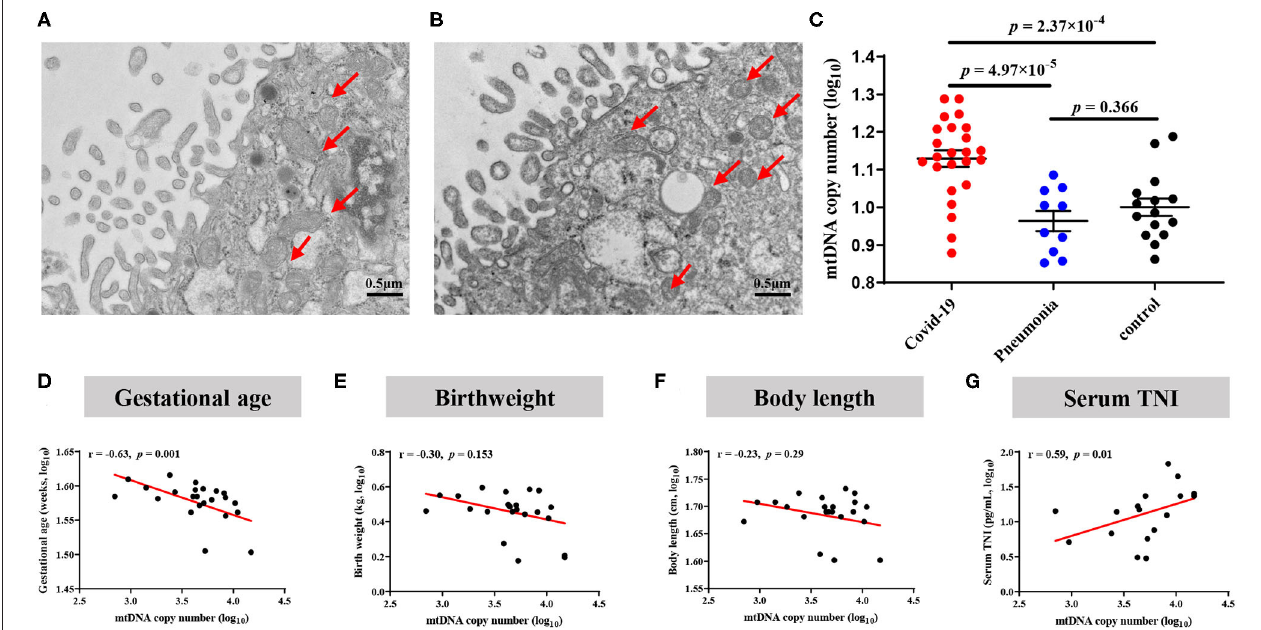
FIGURE 5 | Alterations of mitochondrial morphology and mtDNA copy numbers in placentas. (A) Normal mitochondrial morphology in healthy placentas. (B) Elevated abnormal mitochondria in COVID-19 placentas. (C) Comparison of placental mtDNA copy numbers across COVID-19, pneumonia and Control group. P -values were derived from the Student’s t- test. (D–G) COVID-19 pregnant women with increased placental mtDNA were associated with decreased birthweight. (D) Association of placental mtDNA and gestational age. (E) Association between placental mtDNA and birthweight. (F) Association between placental mtDNA and body length. (G) Association between placental mtDNA and neonatal serum